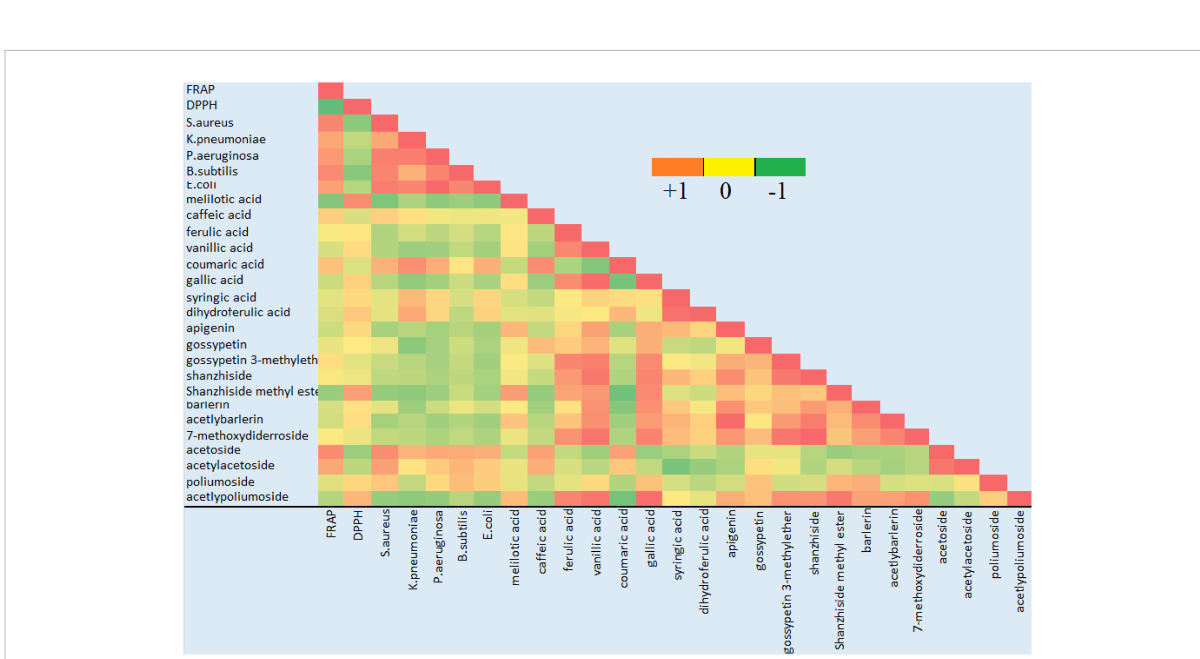
FIGURE 6 Correlation analysis of the identi fi ed compounds with antioxidant and antibacterial activity. Green color indicates negative correlation, red color indicates positive correlation and shades of yellow show no